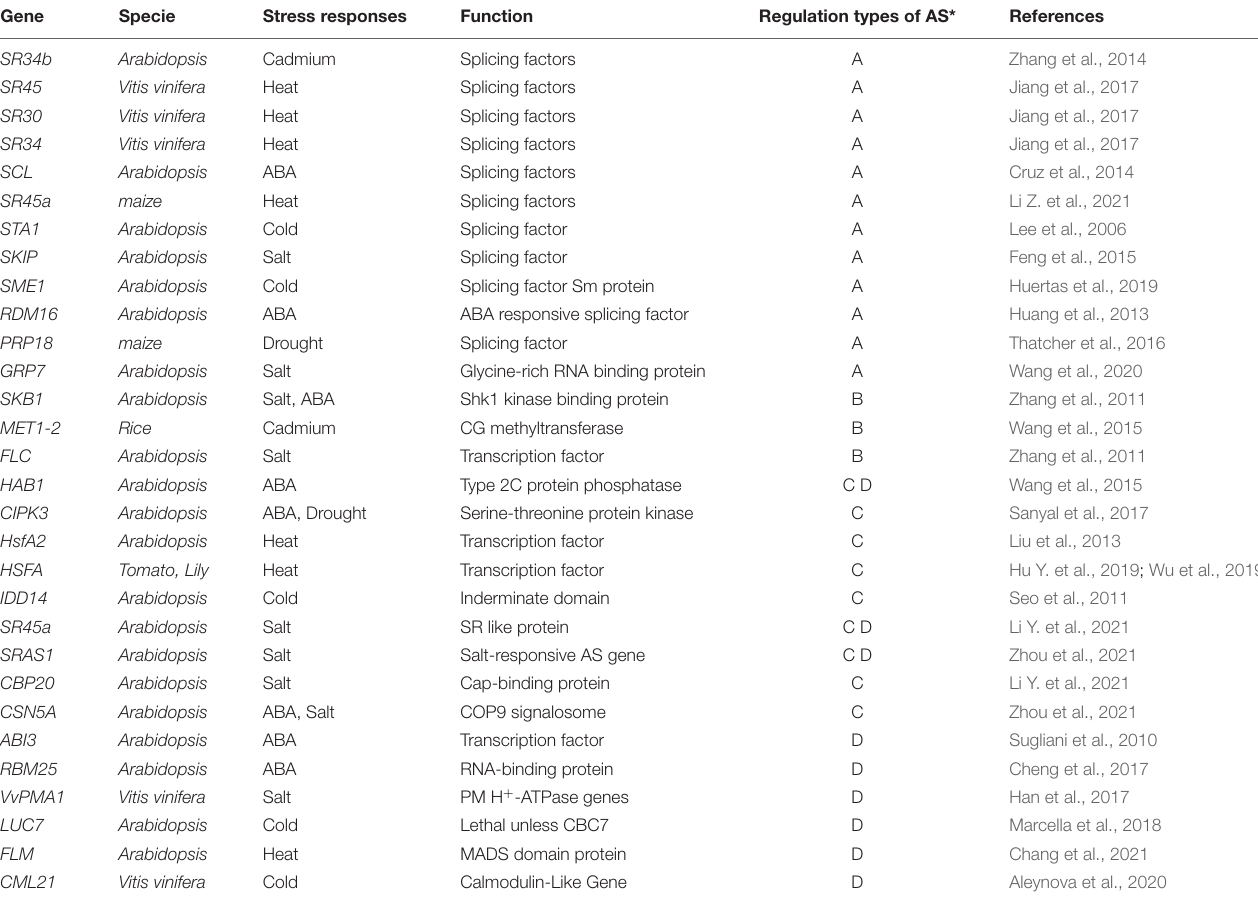
TABLE 1 | A summary of stress-responsive AS